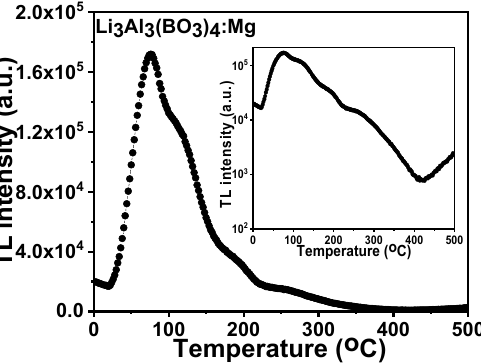
Figure 8. The TL glow curve of 0.1% mole Mg-doped lithium aluminium borate that was irradiated at 50 Gy. The inset identifies the supplementary peaks other than the foremost glow peak. Figure 9 displays a plot of T max alongside T stop estimates with corresponding rangesin 1 °C intervals for Mg ‐ doped lithium aluminum borate. The plot does not show a linear response; however, there was an increase in Tm with Tstop, which was a consequence of partial heating at various points along the glow curve. This demonstrates a second order thermoluminescence which results from overlapping peaks in the TL glow curve.